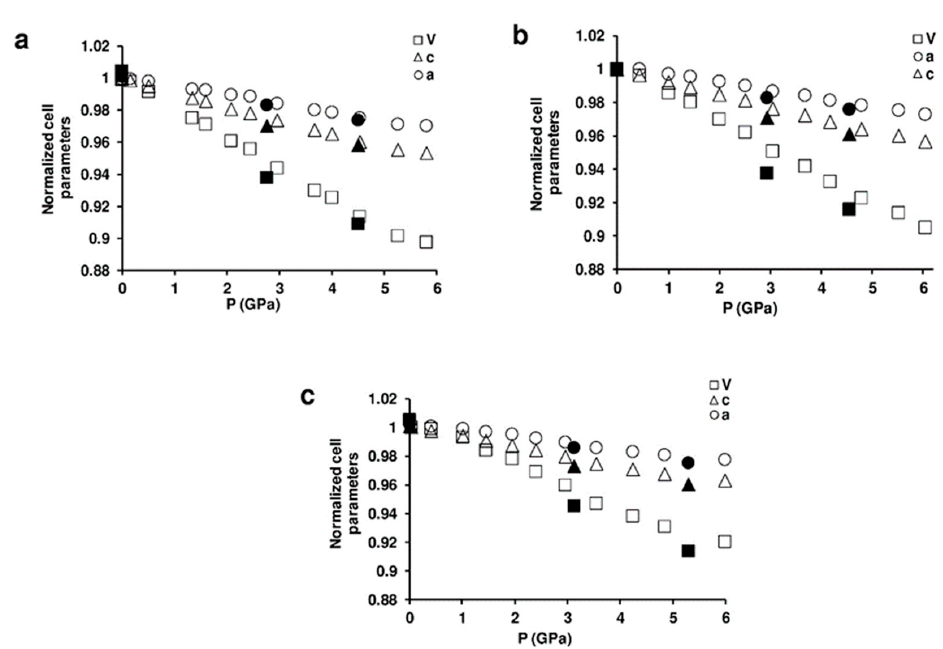
Figure 5. Variations of normalized lattice parameters as a function of pressure for: ( a ) ZL/0.5FL; ( b ) ZL/1FL; ( c ) ZL/1.5FL. The errors associated with the cell parameters are smaller than the symbols used. The full black symbols are associated to decompression ramp. Table 1. Experimental and structural parameters for selected XRPD refinements performed on the ZL/0.5FL and ZL/1FL composites compressed in silicon oil (s.o.) at 2 GPa and upon decompression ( P amb (rev)). 1 From Ref. [56].